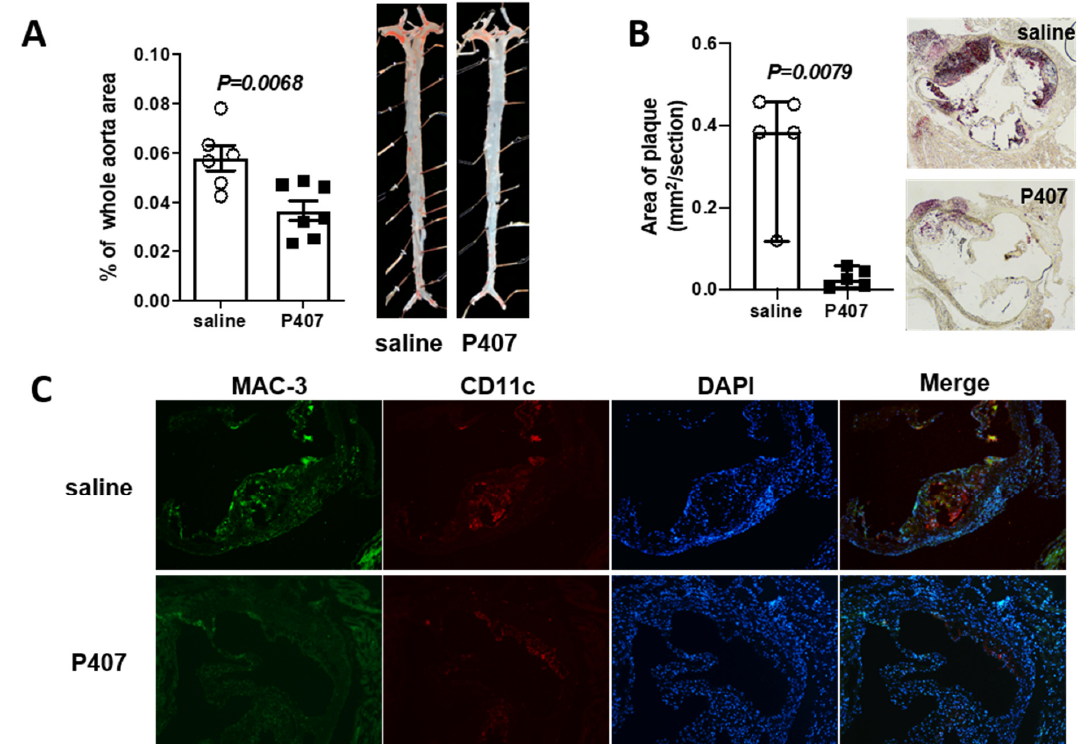
Figure 2. Ldlr –/– mice with P407 injection had reduced atherosclerosis. Ldlr –/– mice were fed the WD and simultaneously injected with P407 or the saline control and were sacrificed at 7 weeks of WD and P407 or saline injection. Atherosclerotic plaque size was quantified in ( A ) whole aortas and ( B ) aortic sinus areas after oil red O staining. Data are presented as ( A ) mean ± SEM or ( B ) median with 95% confidence interval. Unpaired Student’s t -test ( A ) or Mann–Whitney test ( B ) was used for statistical analysis. ( C ) Representative images of macrophages in aortic sinus atherosclerotic plaques after staining for Mac-3 (green), CD11c (red), and DAPI (blue).